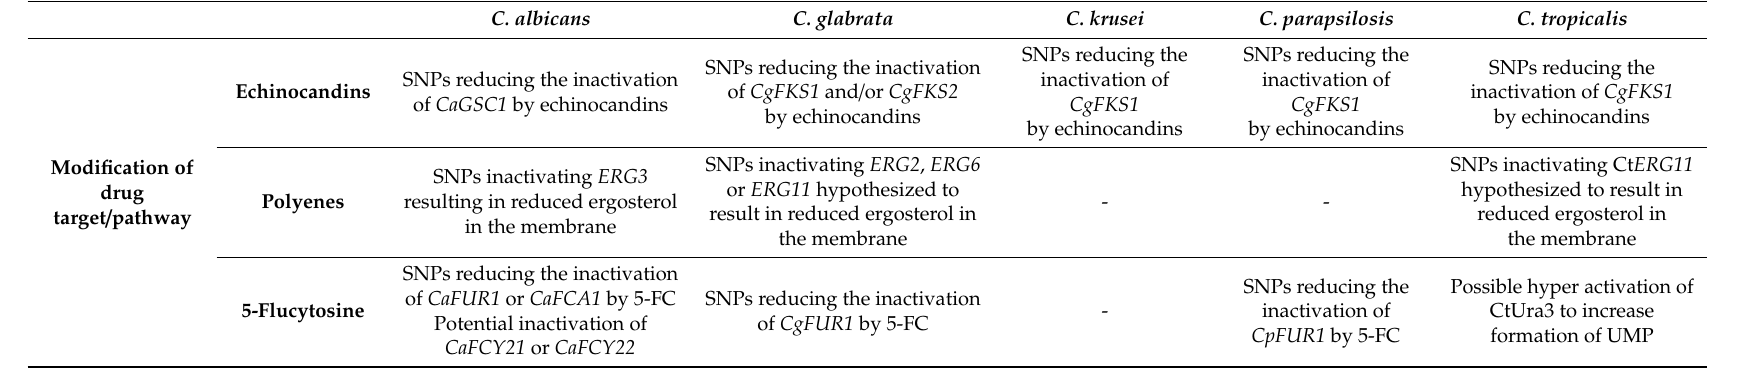
Table 4. Summary of the mechanisms of resistance to echinocandins, polyenes and 5-flucytosine (5-FC) reported in resistant Candida clinical isolates based on results from